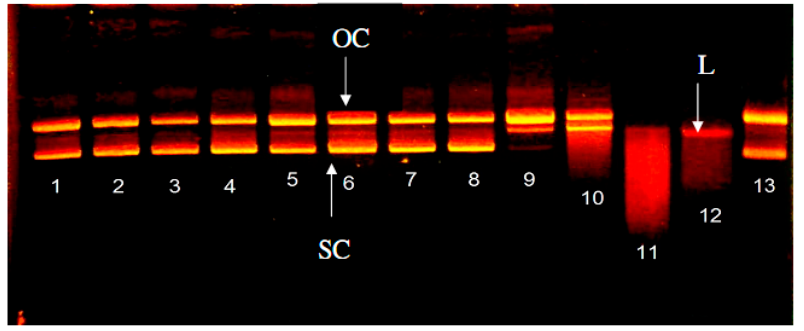
Figure 3. Effect of WPH and WPH fractions on single-strand DNA cleavage induced by Fe 2+ and Fenton reaction. Phage Ψ X174 supercoiled DNA (0.3 μ g) was incubated with Fe 3+ (lane 13); lanes 1–3: